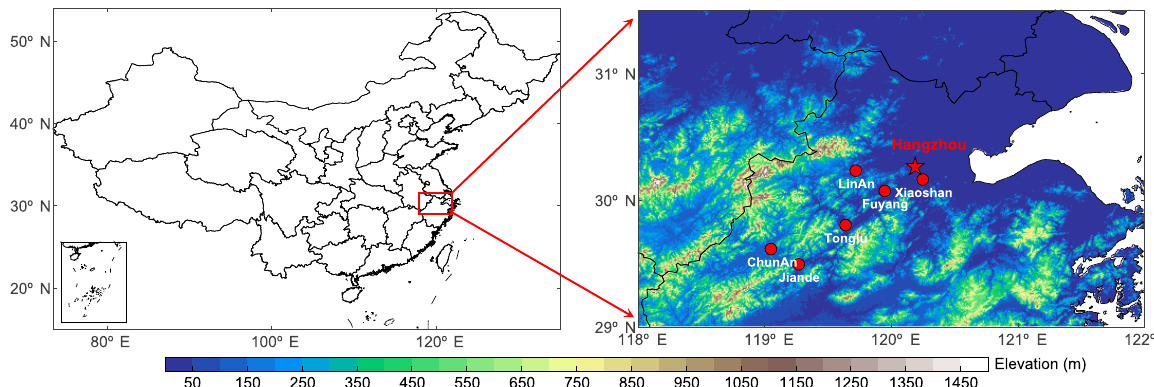
Figure 1. Locations and elevations of the seven CARSNET sites in the Yangtze River